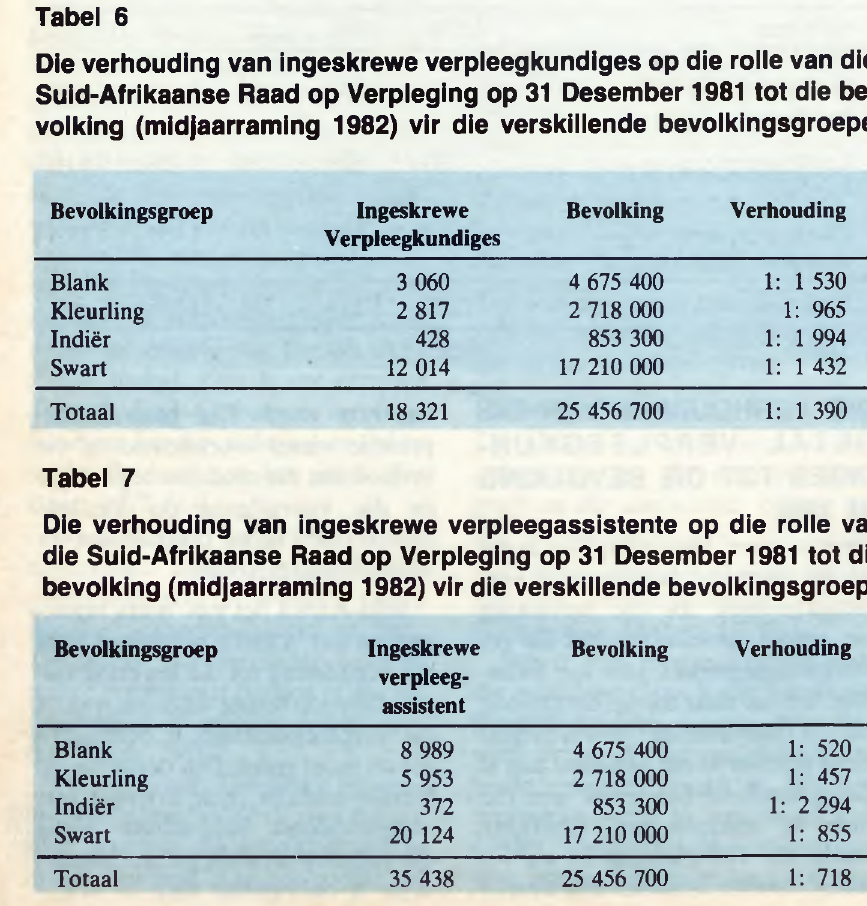
Die verhouding van ingeskrewe verpleegkundiges op die rolle van die